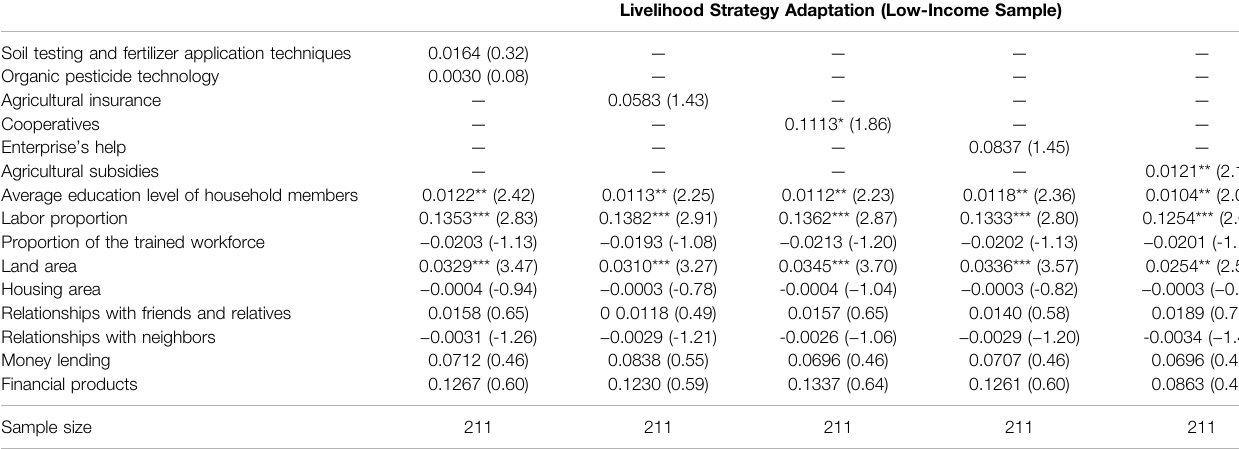
TABLE 5 | Regression results for the low-income sample.